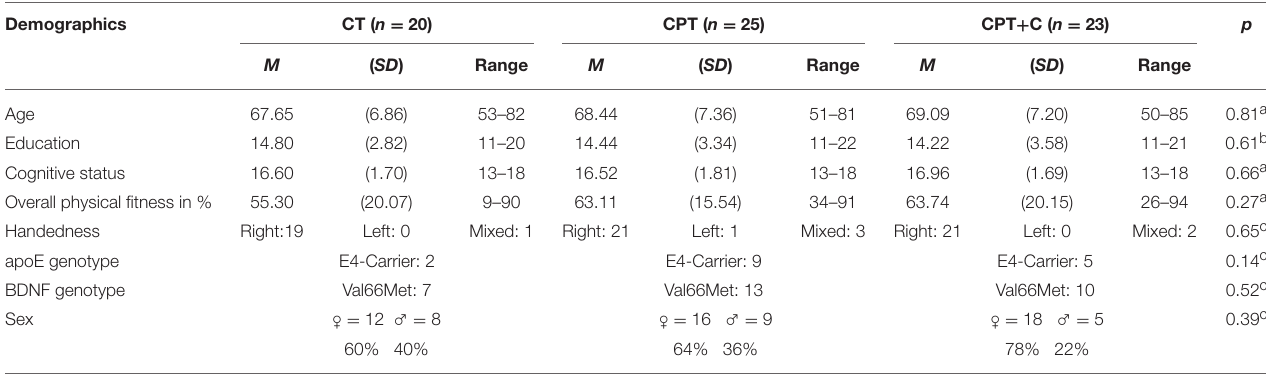
TABLE 1 | Baseline characteristics of the study